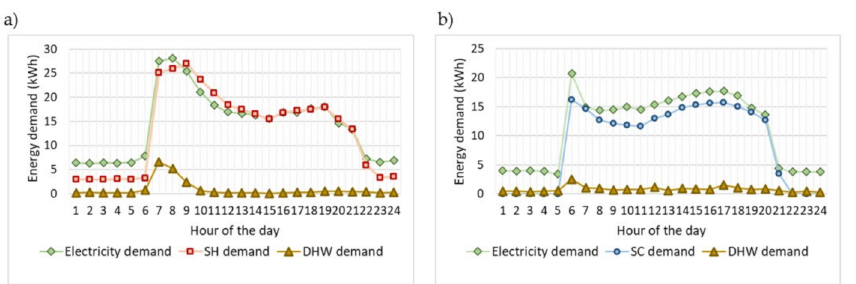
Figure 15. Hourly electrical and thermal demand profiles for the SEB: ( a ) representative winter day; ( b ) representative summer day.